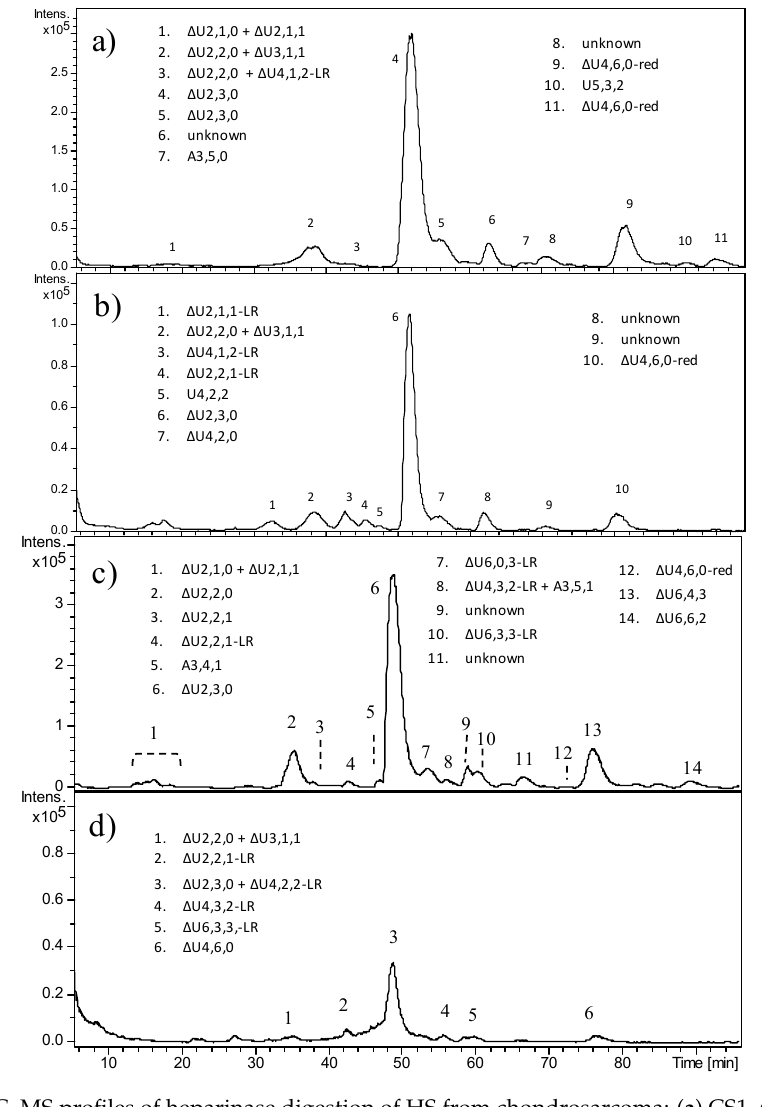
Figure 7. LC–MS profiles of heparinase digestion of HS from chondrosarcoma: ( a ) CS1-A, ( b ) CS1-B, ( c ) CS3-A, and ( d ) CS3-B. For some m / z ratios, more than one oligosaccharide structure was possible. When a uronic acid (or a glucosamine) is present at both the RE and NRE, it is indicated by U (or A). LR indicates the tetrasaccharide linkage region G-Gal 2 -Xyl. Oligosaccharides for which an imprecise interpretation was found were labeled as “unknown”.